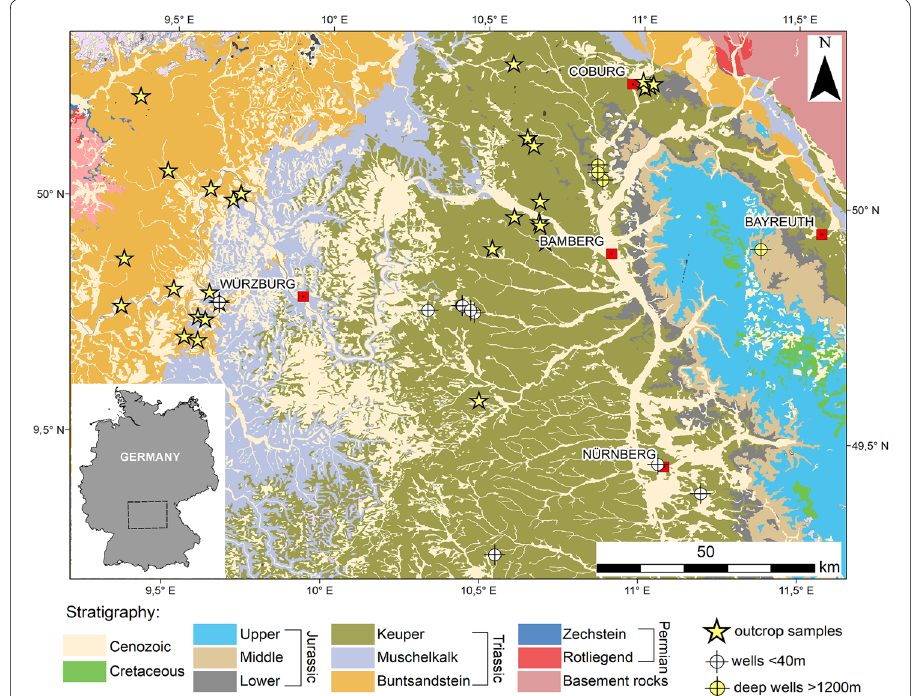
Fig. 1 Geological map showing core and outcrop sampling locations of sandstones. Map compiled from Berger et al. (1977), Emmert et al. (1981), Freudenberger and Zitzmann (1994), Meyer et al. (1994), Seidel et